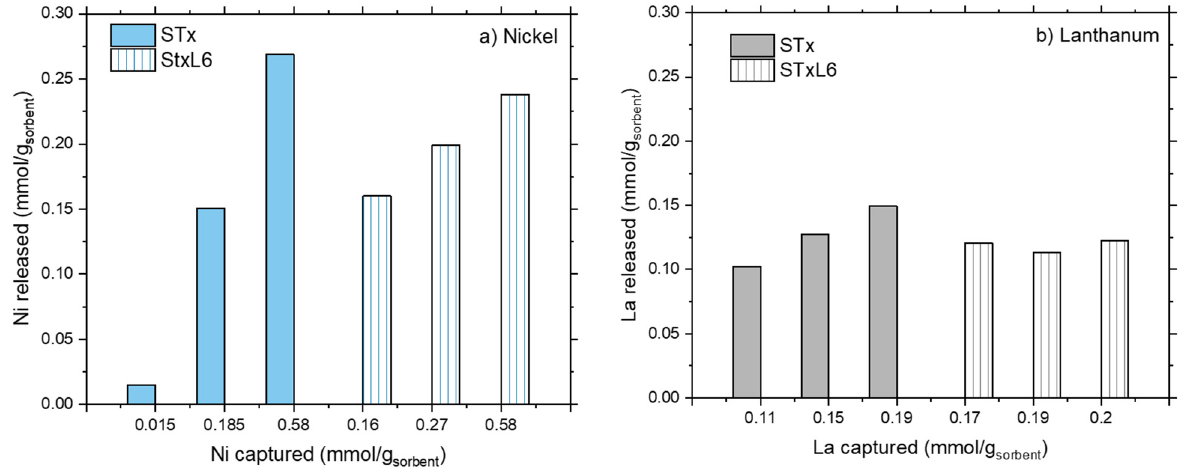
Figure 3. Metal release as a function of the metal captured for STx and STxL6.